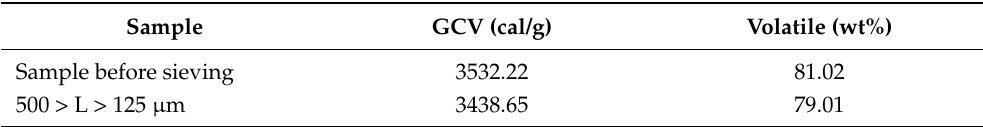
Table 6. Thermogenic measurement of Posedonia oceanica